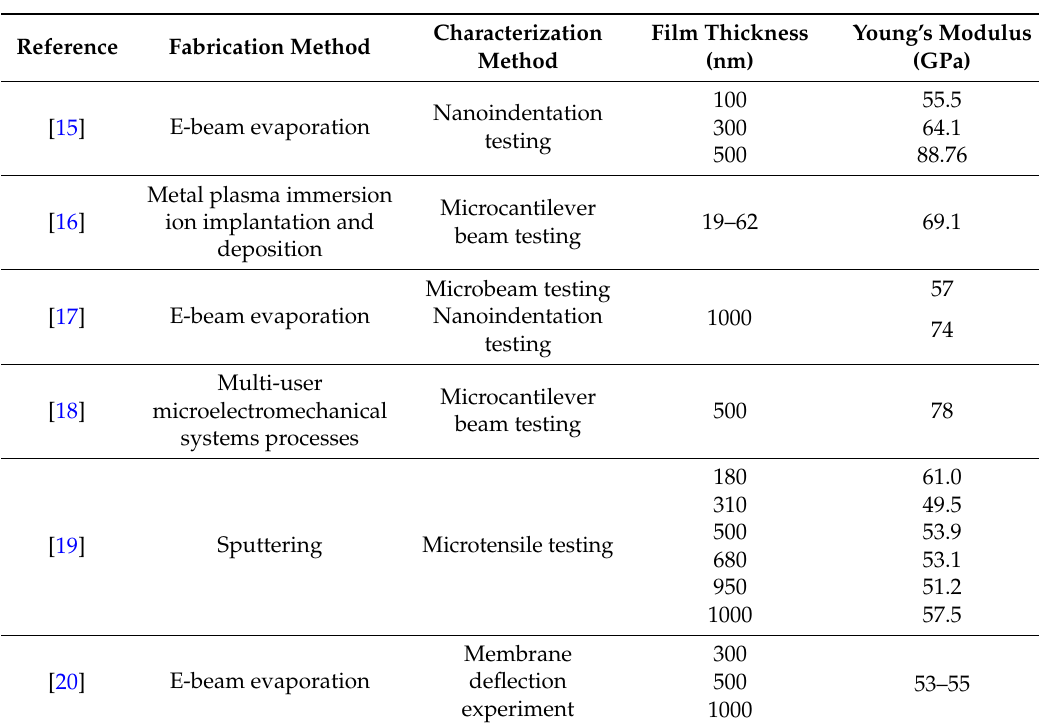
Table 2. Young’s moduli of gold thin-films from